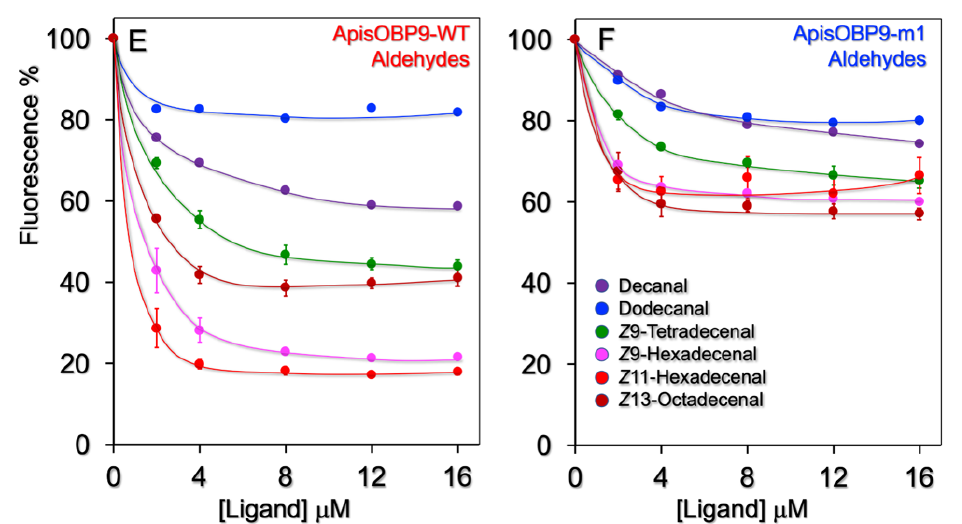
Figure 2. Ligand-binding experiments with ApisOBP9 and its mutant ApisOBP9-m1 (K37L). ( A ). Both WT and mutant ApisOBP9 bind 1-NPN with good affinities. ( C , E ). ApisOBP9 binds linear alcohols and aldehydes of 14–18 carbon atoms. ( B ). The protein is narrowly tuned to 16-carbon linear alcohols and aldehydes. ( D , F ). Replacing Lys37 with Leu in ApisOBP9-m1 had the effect of strongly reducing the affinity to long-chain alcohols and aldehydes, specifically to the 16-carbon members.